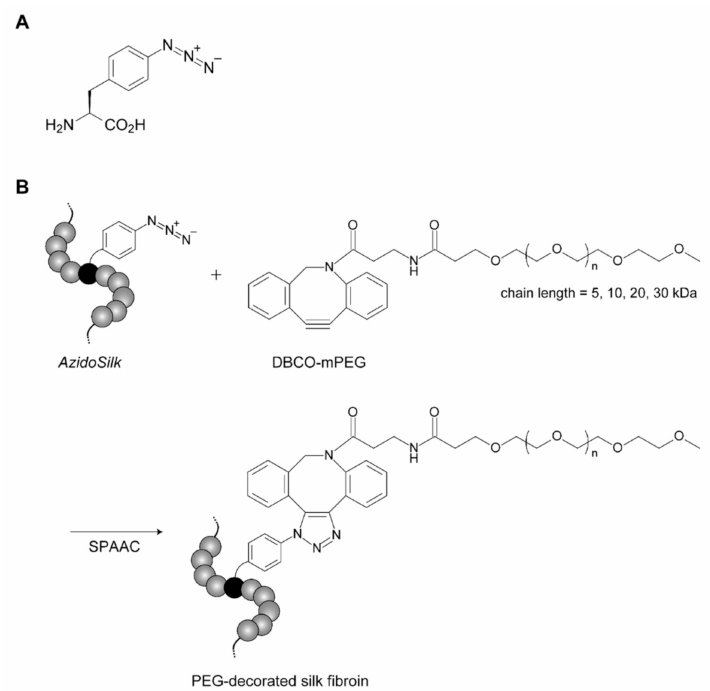
Figure 1. Click decoration of AzidoSilk with PEG (polyethylene glycol) chains by SPAAC (strain-promoted azido-alkyne cycloaddition) between an azido group and a DBCO (dibenzylcyclooctyne) group. ( A ) Structure of AzPhe (4-azido- l -phenylalanine). ( B ) Reaction scheme of AzidoSilk with DBCO-mPEG (DBCO-functionalized methylated PEG reagents) by